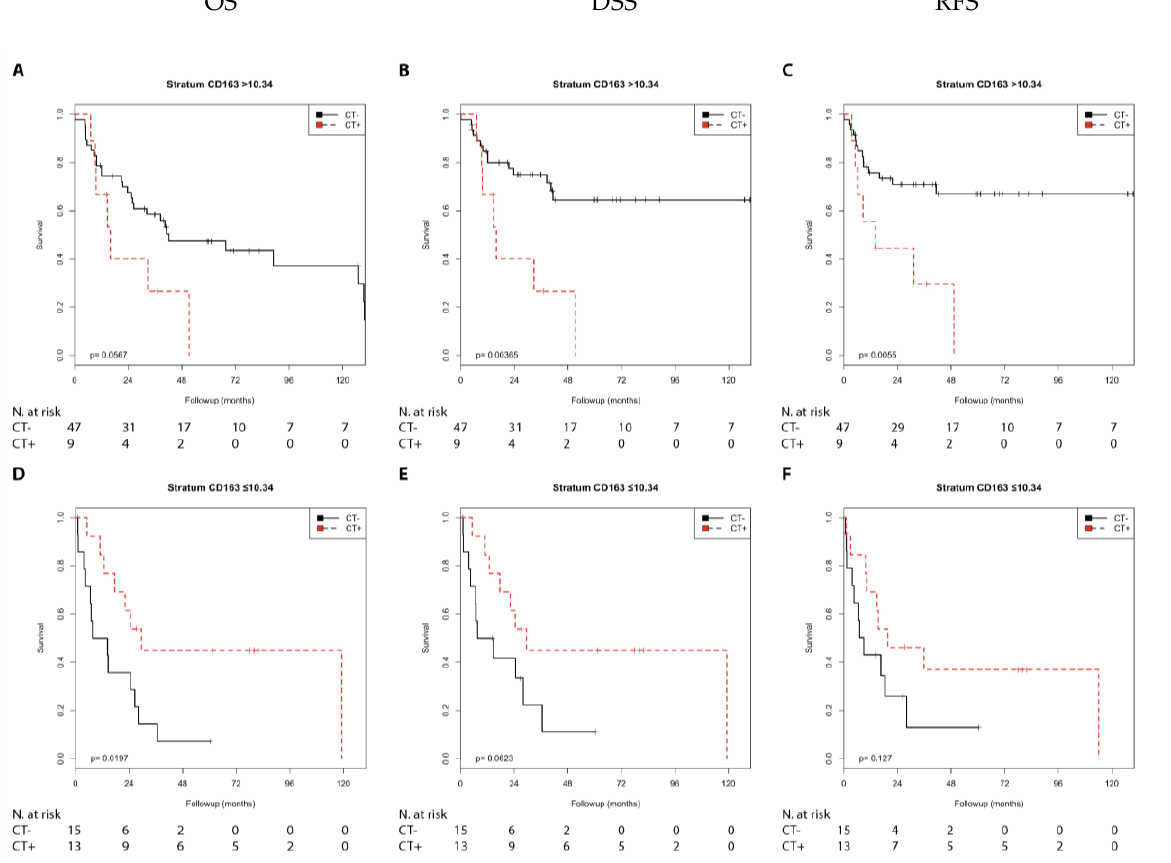
Figure 7. Kaplan–Meier analysis: Association of chemotherapy with prognosis (OS, DSS, and RFS) in the N0/N1 + 2 groups stratified by CD163 expression (>10.34 or ≤ 10.34). In the N0 group ( A – C ) with CD163 (>10.34), chemotherapy was not associated with OS ( A ) but was associated with shorter DSS ( B ; p = 0.004) and shorter RFS ( C ; p = 0.006). In the N1 + 2 group ( D – F ) with CD163 ( ≤ 10.34), chemotherapy was associated with longer OS ( D ; p = 0.020), but not with DSS ( E ) or RFS ( F ).